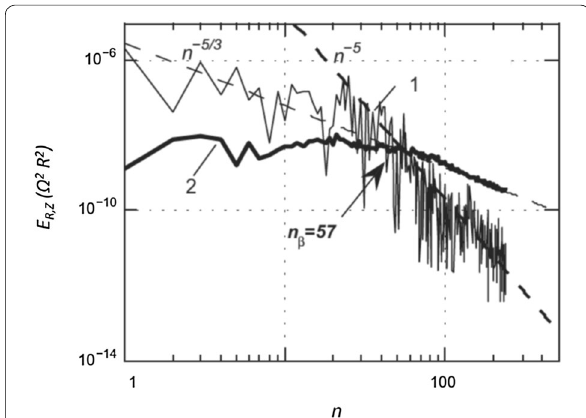
Fig. 1 Kinetic energy spectrum of Jupiter’s cloud layer (in units of Ω 2 R 2 ), obtained by Galperin et al. (2014) from Cassini images. Spectra are projected onto spherical harmonics (with total wavenumber index n ) and decomposed into the zonal mean flow E Z ( n ) (1, thin line) and residual KE E R ( n ) (2, thick line), such that total energy E T ( n ) E Z ( n ) E R ( n ). The analysis used the CB2 filter images with a = + native resolution of 0.05° pixel − 1 and a correlation box size of 0.95°, corresponding to a spectral resolution limit of around 1° or n